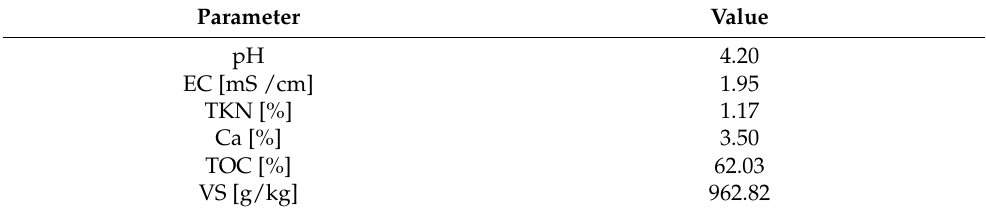
Table 1. Chemical characteristics of grocery waste-based compost.